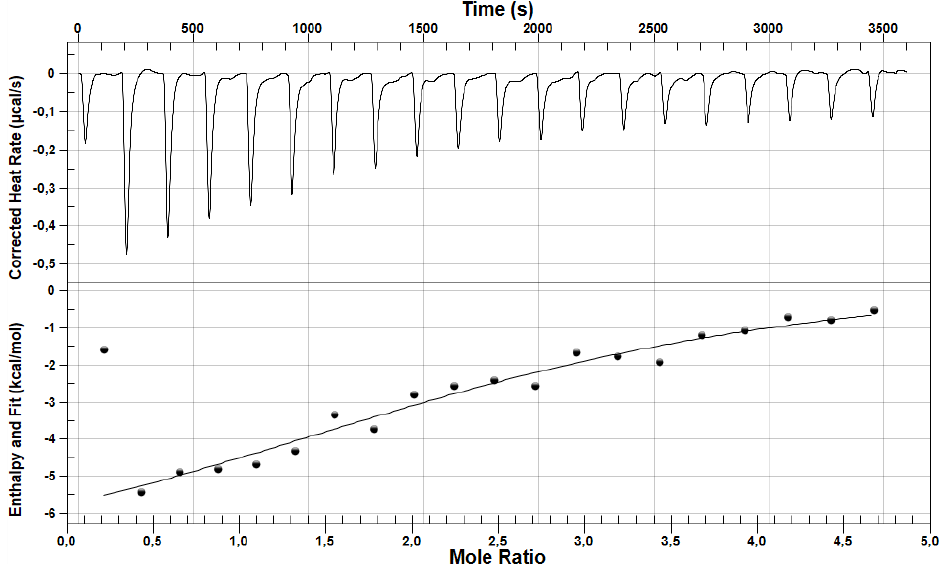
Figure 4. A nanoITC thermogram of albumin in the presence of FUR (FUR:HSA ~0.2:1 ÷ ~4.7:1 molar ratio); the upper figure shows the raw heat data obtained from the consecutive injections while the lower figure presents binding isotherm created by plotting areas of the heat peak in relation to the molar ratio of furosemide to albumin. The lines present the best fit of the models used. T = 298 [K]. NanoAnalyze Data Analysis Version 3.10.0 (TA Instruments, New Castle, DE, USA).